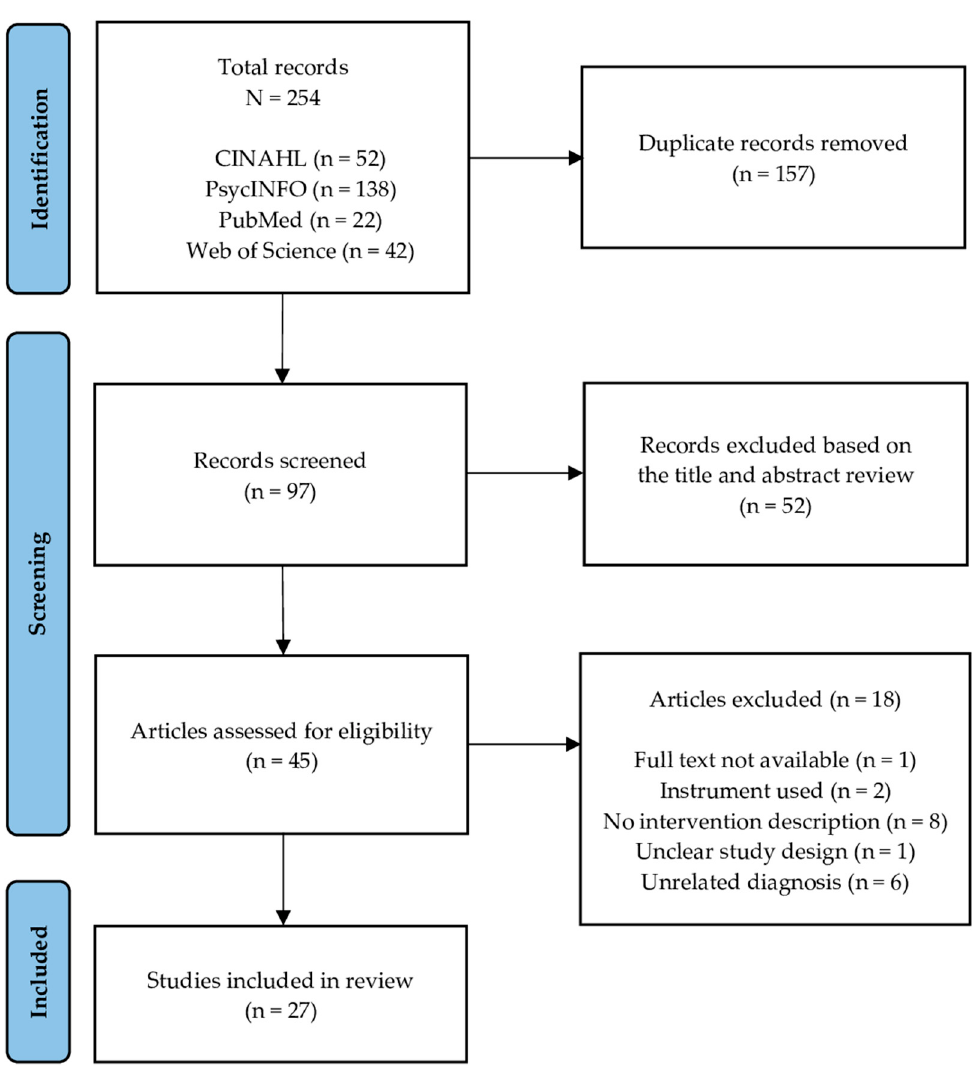
Figure 1. PRISMA flowchart describing the selection process of the included articles.